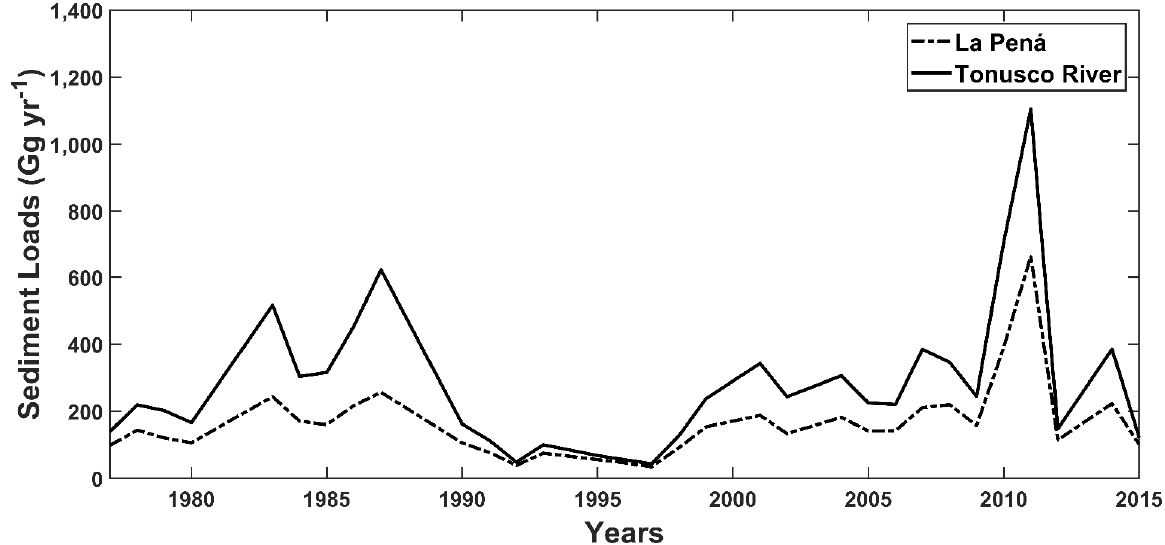
Figure 14. Comparison between the estimated sediment produced in the La Pená subbasin and measured in the Tonusco basin.